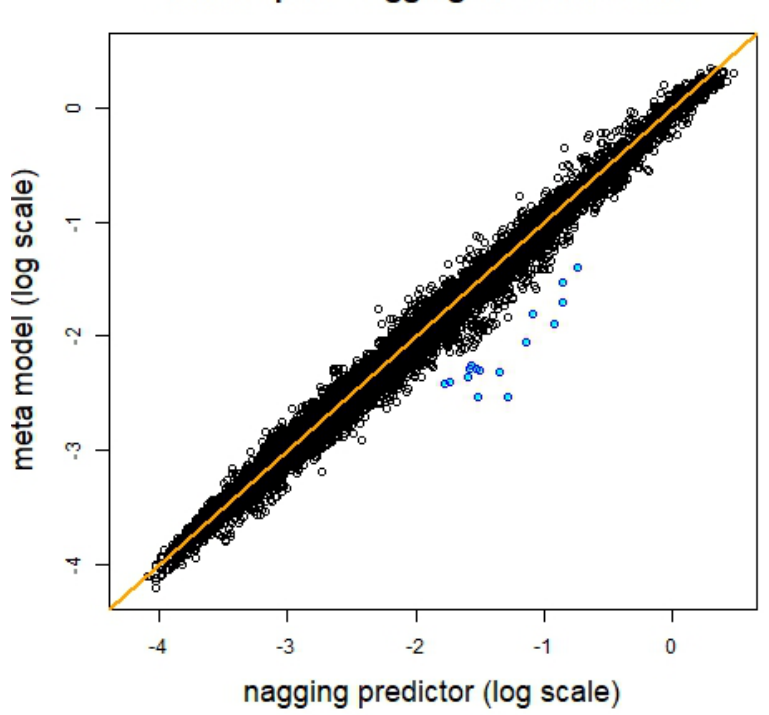
Figure 9. Comparison of nagging predictors and meta model